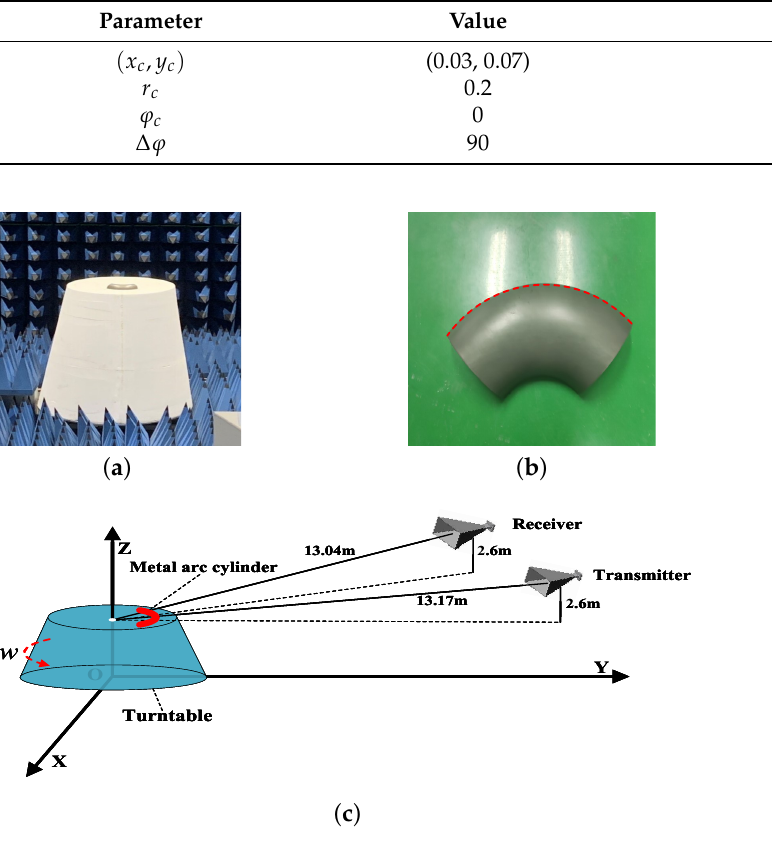
Figure 14. Target and observation geometry for the real-data experiments: ( a ) metal arc cylinder on the turntable. ( b ) detail of metal arc cylinder. ( c ) observation